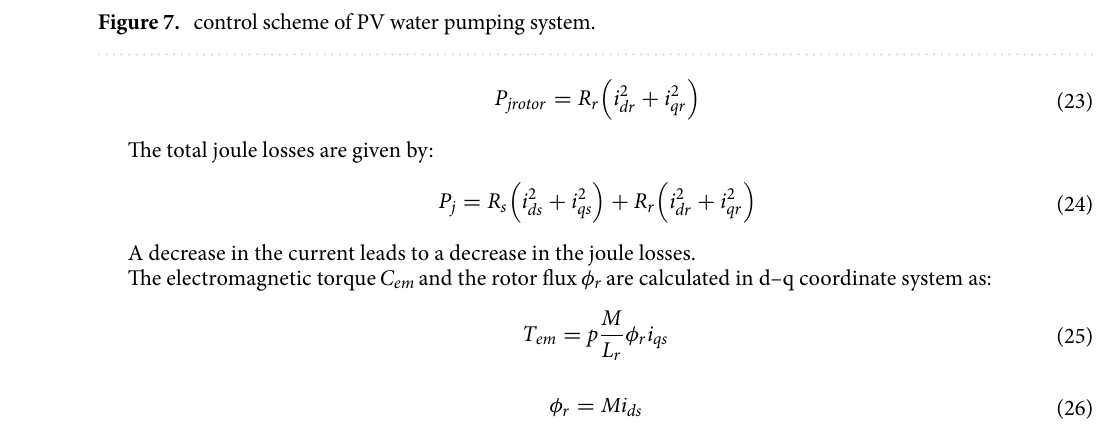
Figure 7. control scheme of PV water pumping